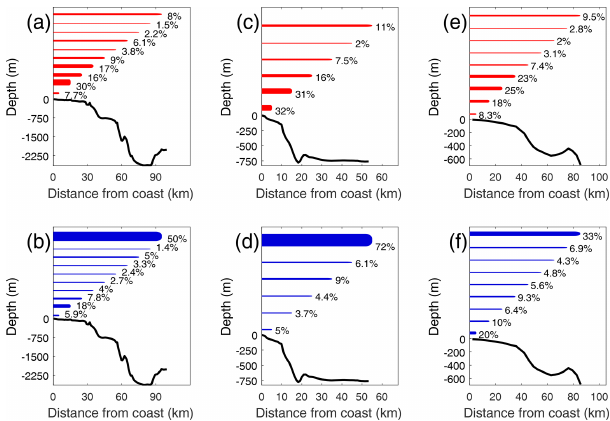
Figure 9. Percentage of the offshore extent (from the coast) of alongshore flows (PF: red; EF: blue) at transects TrW (a–b) , TrCSM (c–d) and TrE (e–f) . Each bar represents the distance from the coast, and bar thickness indicates the percentage. The along- transect bathymetry is represented as a black